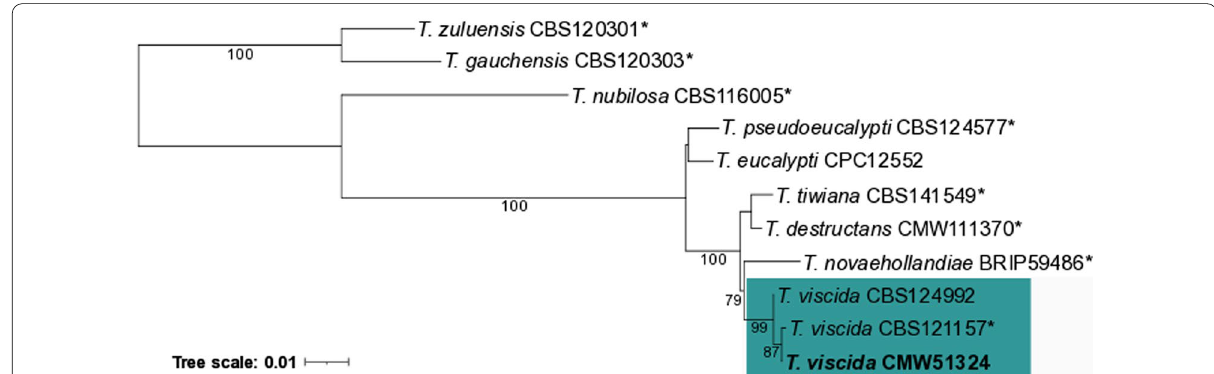
Fig. 5 Maximum likelihood phylogeny of the concatenated Beta‑tubulin, EF‑1α and ITS gene regions indicating the taxonomic position of the Teratosphaeria viscida genome isolate (bold). Type isolates are indicated with an asterisk (*). Support values represent the transfer bootstrap expectation metric (TBE) of Lemoine et al. (2018). GenBank accession numbers are available in Quaedvlieg et al. (2014) and Andjic et al.